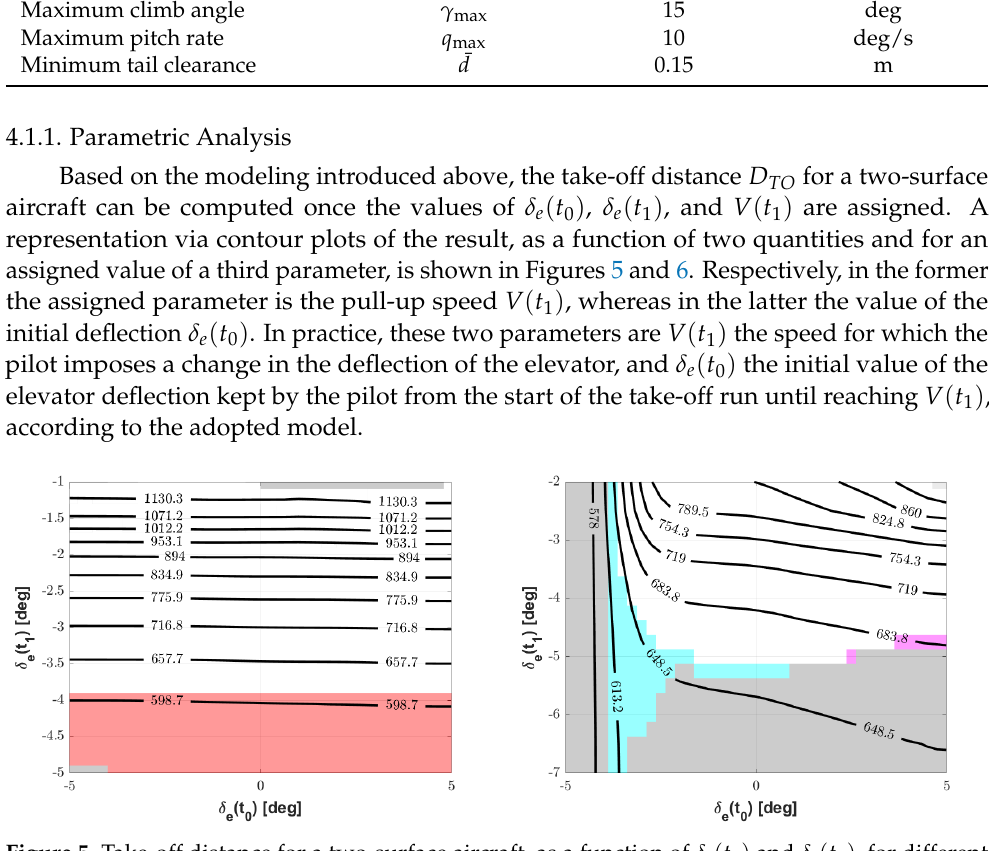
Figure 5. Take-off distance for a two-surface aircraft, as a function of δ e ( t 0 ) and δ e ( t 1 ) , for different assigned V ( t 1 ) . ( Left ): V ( t 1 ) = 72 kn (37 m/s). ( Right ): V ( t 1 ) = 85 kn (44 m/s). Red area: tail strike. Purple area: excessive pitch rate. Cyan area: take-off before control pull-up. Grey area: two or more constraints